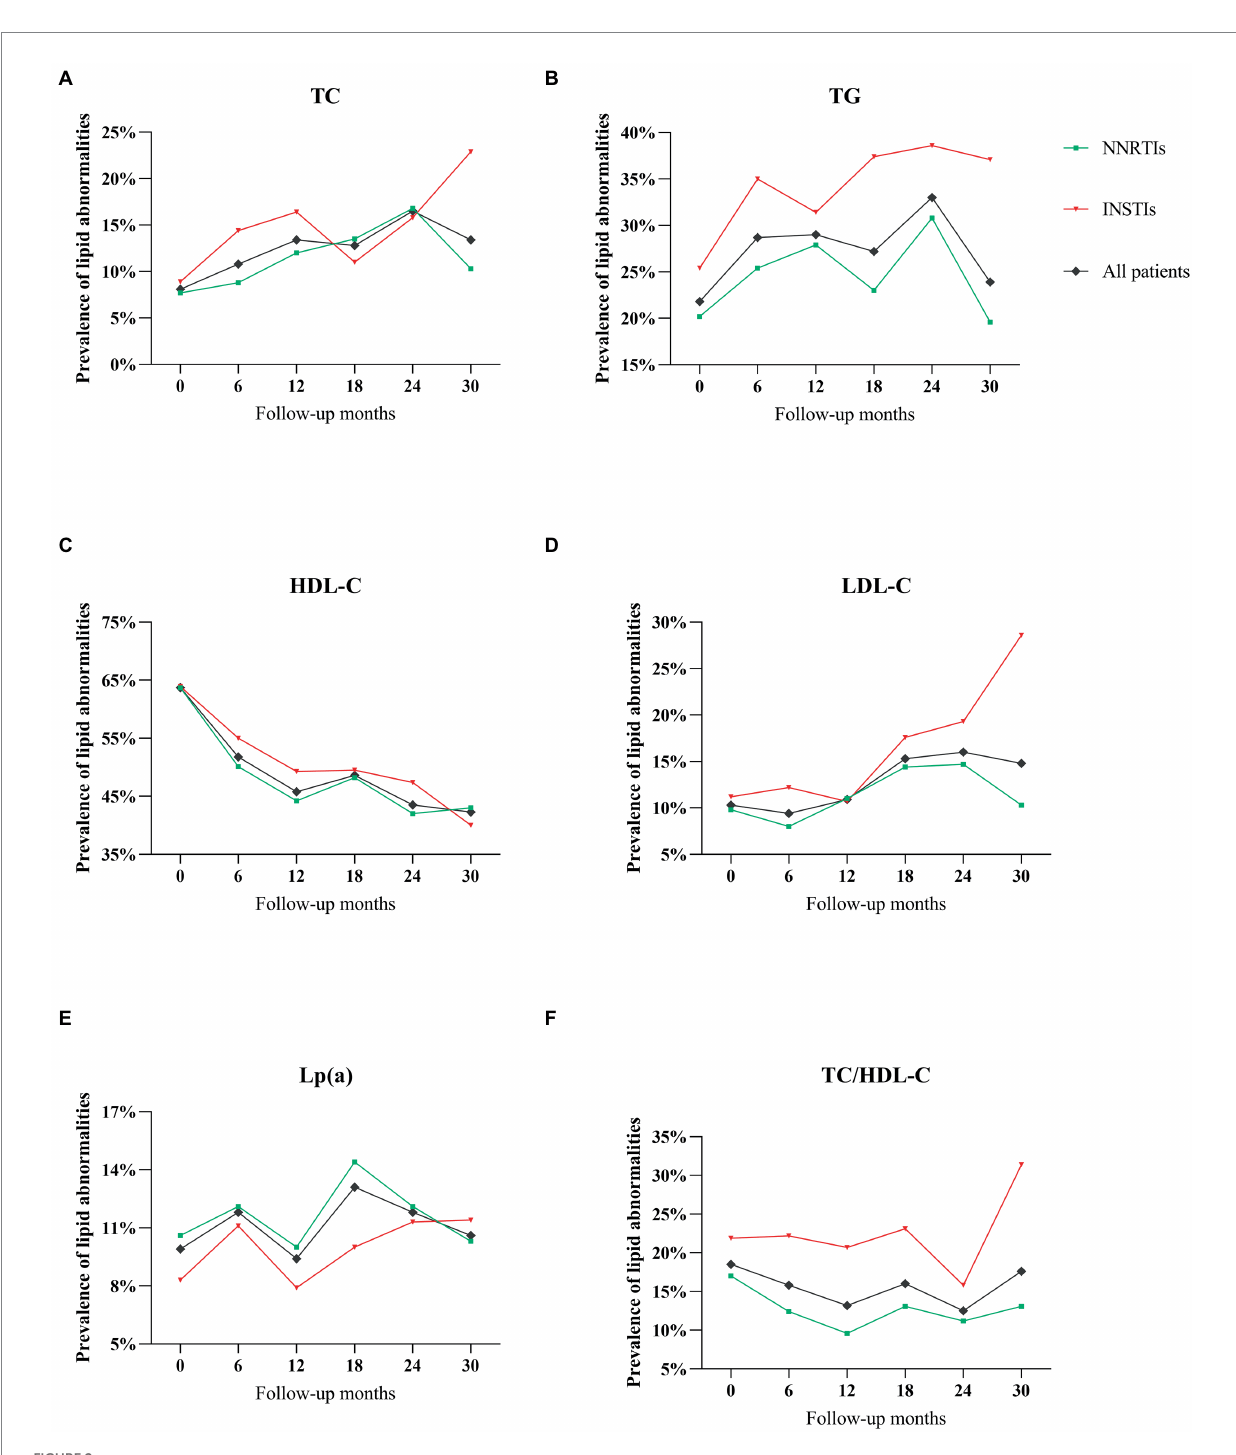
FIGURE 2 (A) The prevalence of abnormal total cholesterol during follow-up period with NNRTIs vs. INSTIs. (B) Triglycerides throughout the follow-up period. (C) HDL-cholesterol. (D) LDL-cholesterol. (E) Lipoprotein(a). (F) TC/HDL-C